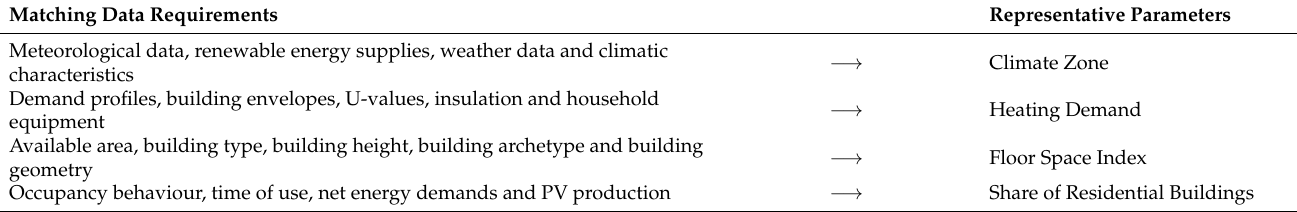
Table 1. The synthesis of parameters for the district